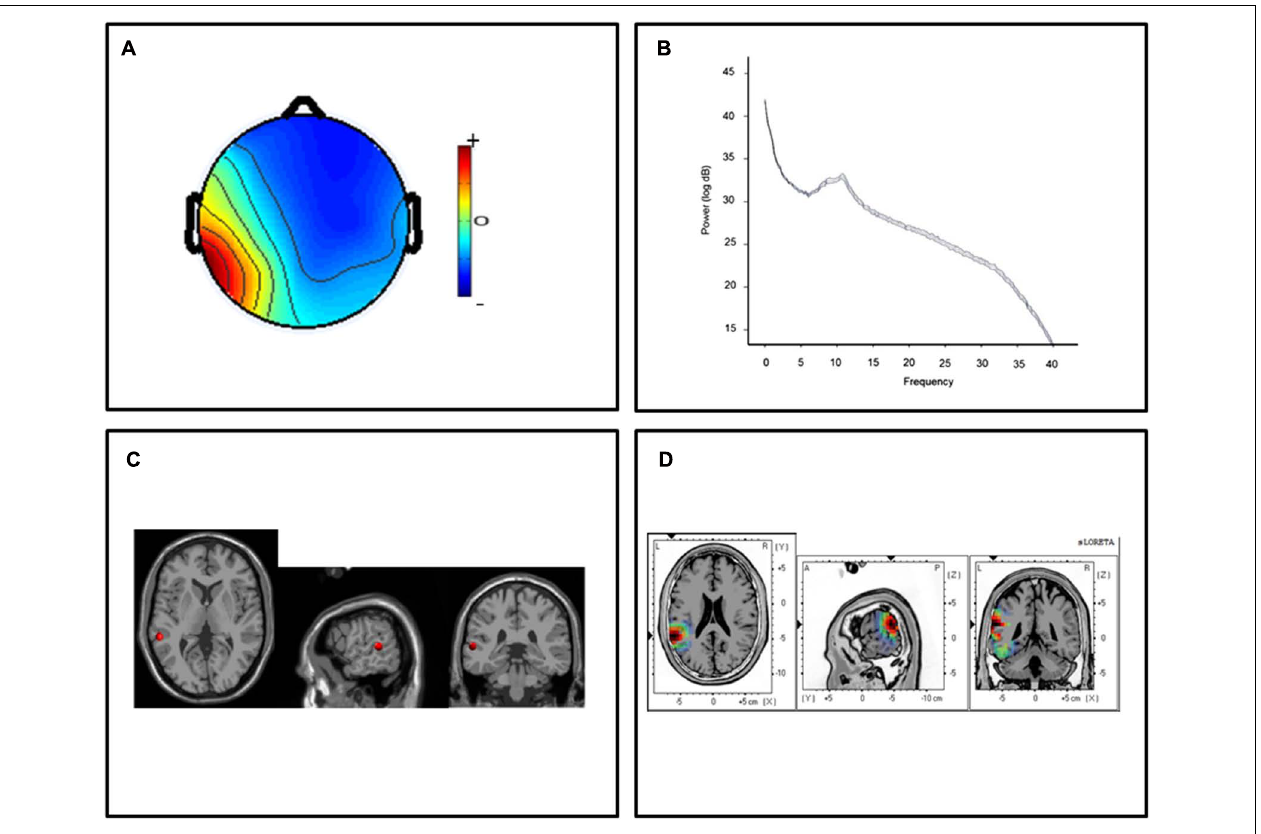
FIGURE 1 | Cluster results for the left-hemisphere α component. (A) Mean scalp potential distribution (W − 1 ) scaled to RMS microvolts and individual scalp distributions for each participant. (B) Mean spectra of the component across cluster ICs. (C) Average equivalent current